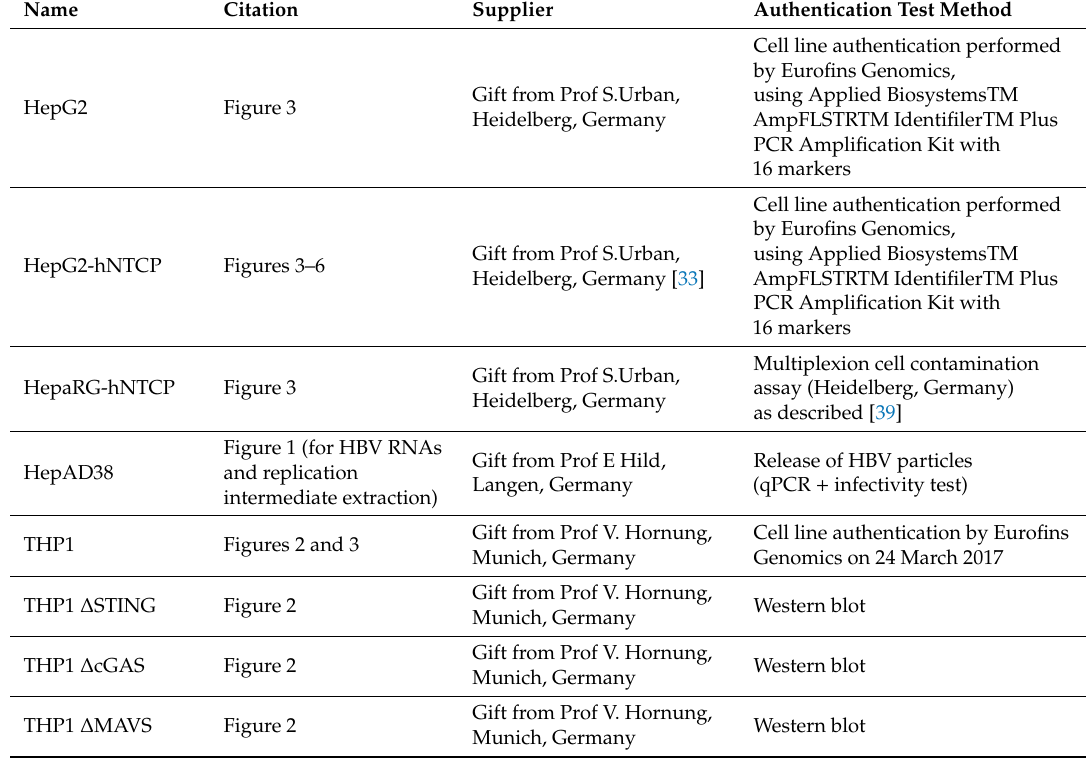
Table 1. Cell lines, suppliers and authentication